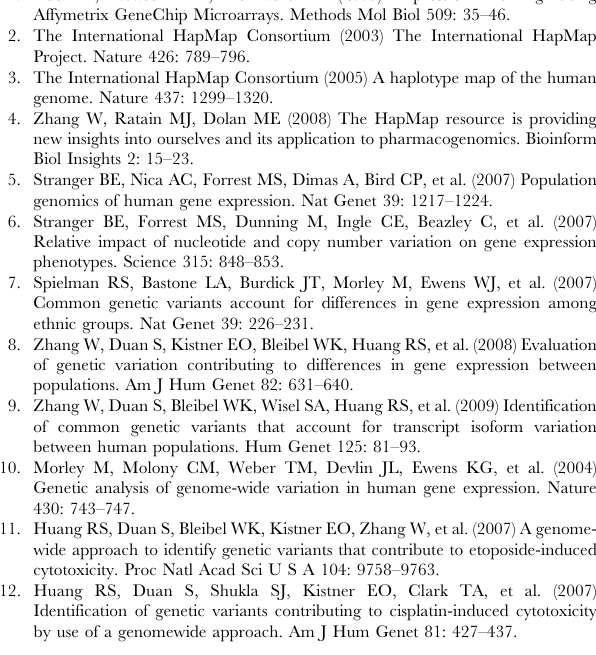
Table S7 The breakdown of affected probesets under the